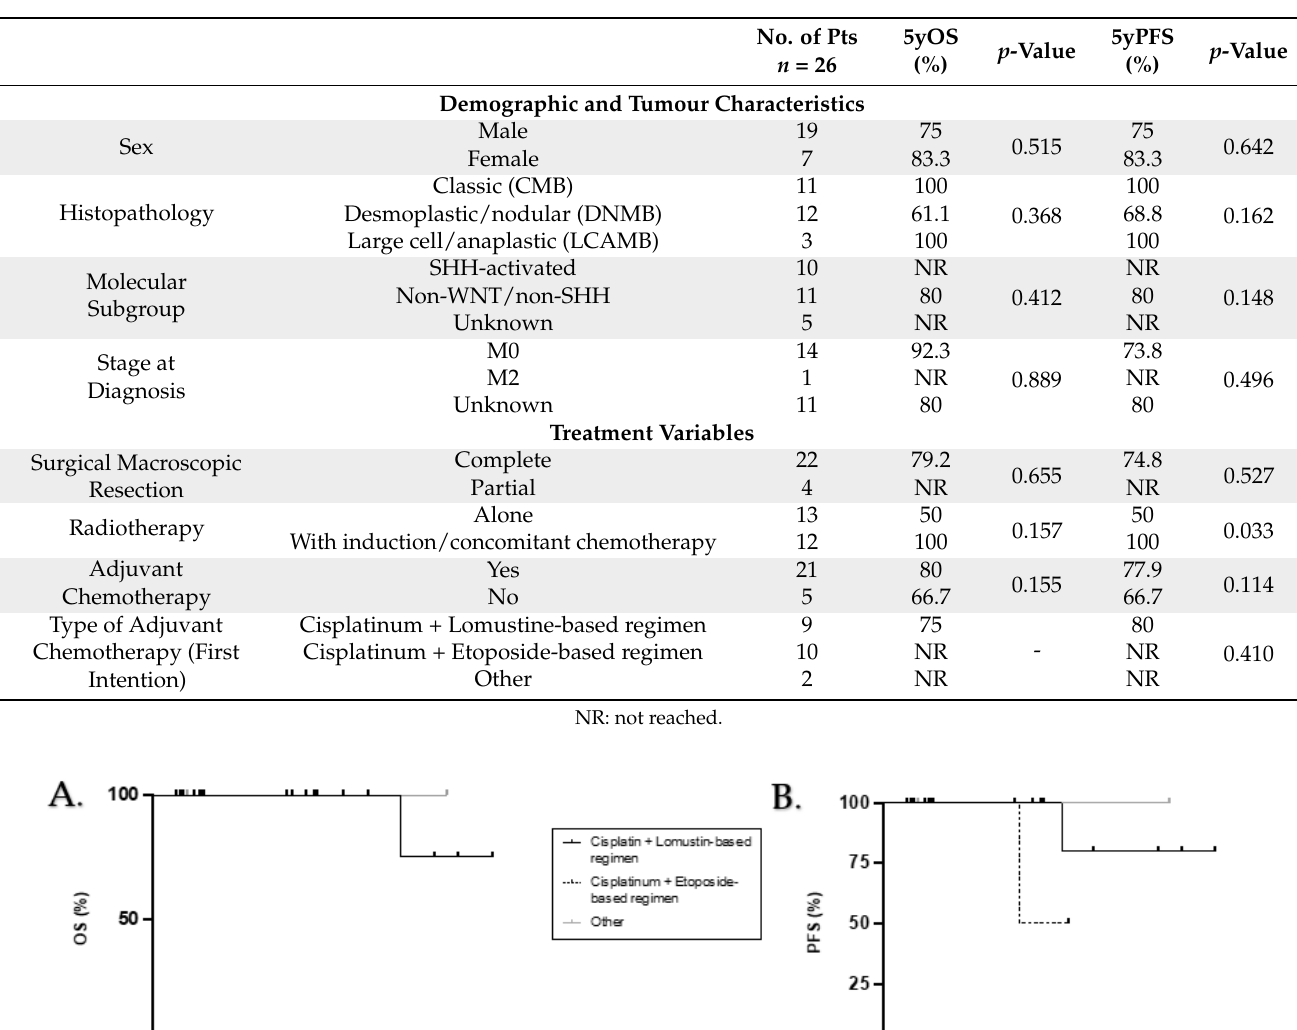
Table 3. Univariate Analysis on the Impact of Patient, Tumour and Treatment Characteristics on Overall and Progress-Free Survival in Adult Patients.